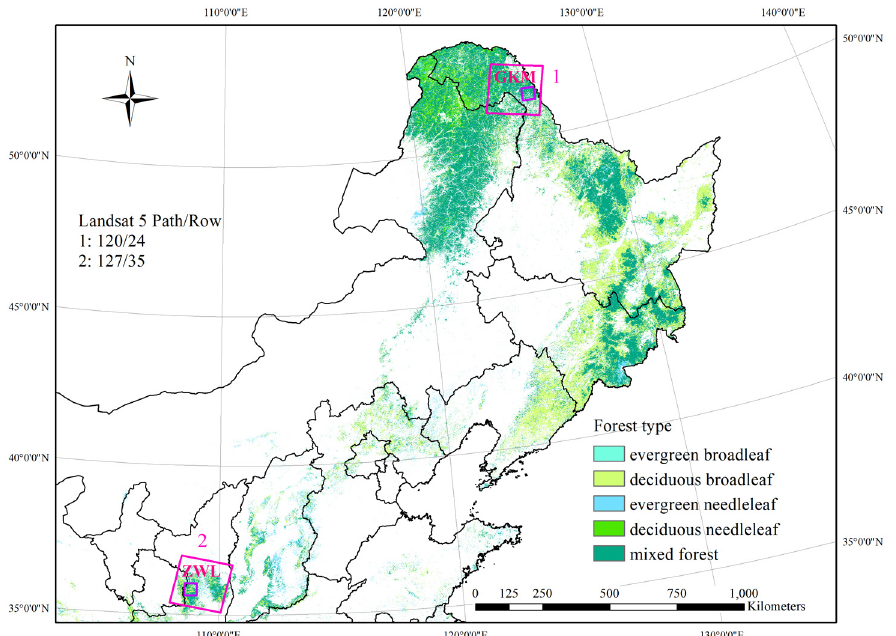
Figure 1. Location of the study area, region of interest (purple regions in Box 1 and Box 2), and coverages of Landsat 5 scenes labeled by Worldwide Reference System 2 (WRS-2) path/row for the study area in the Greater Khingan Mountains (GKM, Box 1) and Ziwuling Mountains (ZWL, Box 2). The background data showed different forest types from Li et al. [41] with mapped colors described in the legend.